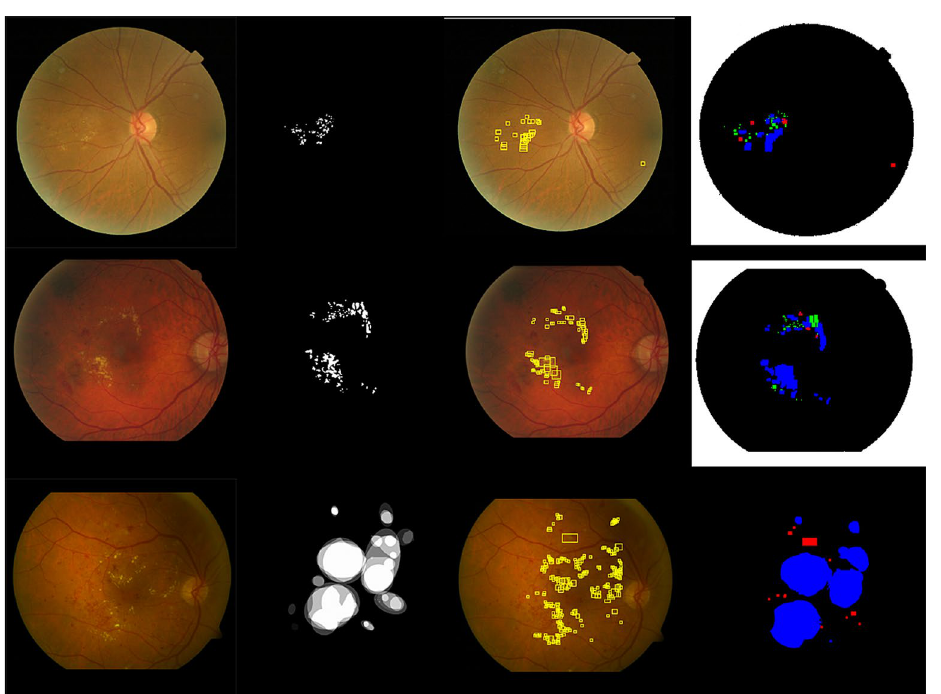
Figure 5. Results of the proposed method. First two rows are examples from the e-ophtha-EX dataset; last row is from the DiaretDB1 dataset. The first, second, third, and fourth columns show the original images, ground- truth data, object detection results, and evaluation map, respectively. The true positives, false negatives, and false positives are denoted in blue, green, and red,